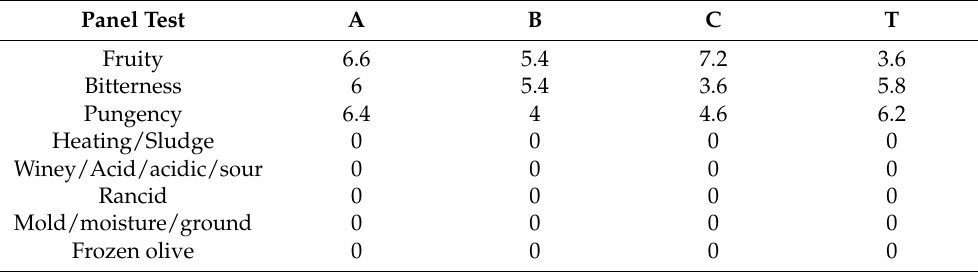
Table 4. Panel test of oils treated with three biostimulants: A (tropical plants extract), B (glycine betaine), and T ( Trichoderma ) all compared with C